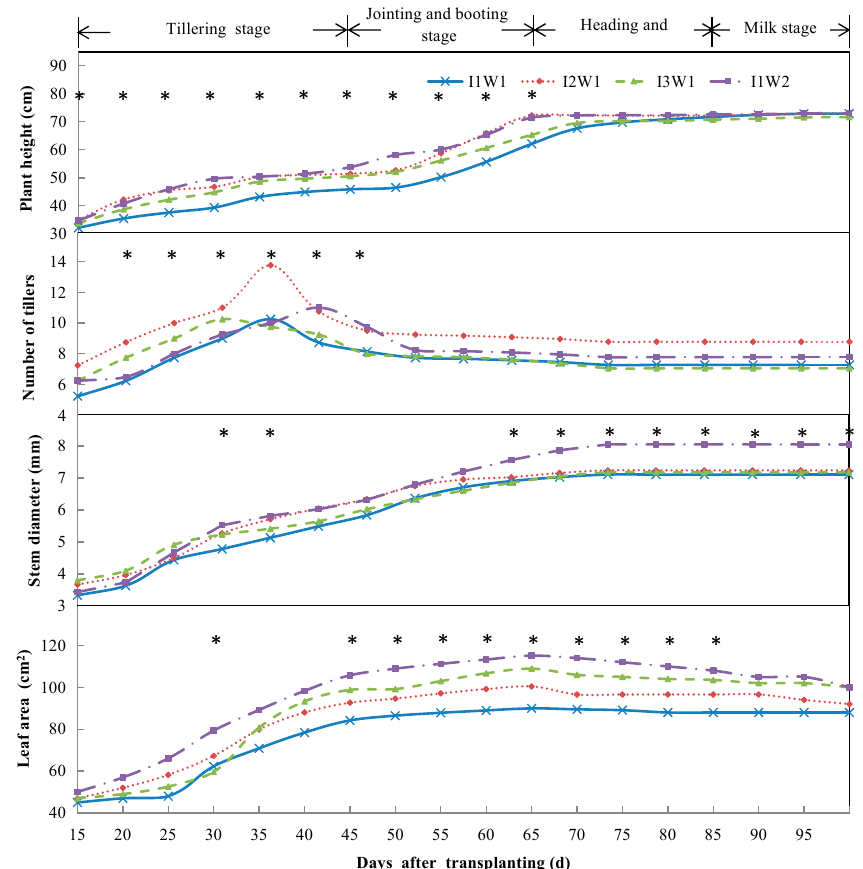
Figure 6. Temporal variation of growth parameters in di ff erent irrigation treatments. DAT denotes days after transplanting. I1W1 represents shallow–frequent irrigation with aquaculture wastewater; I2W1 represents shallow–wet irrigation with aquaculture wastewater; I3W1 represents flooding irrigation with aquaculture wastewater; I1W2 represents shallow–frequent irrigation with fresh water. Asterisks indicate where means of one treatment growth index was significantly di ff erent from another growth index (Duncan test, p ≤ 0.05).